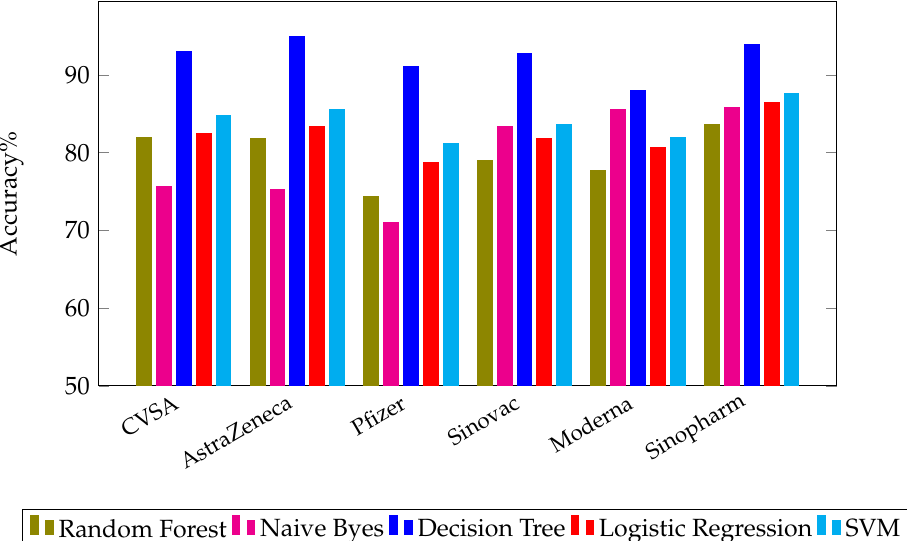
Figure 14. Performance comparison of machine learning algorithms on datasets used in the